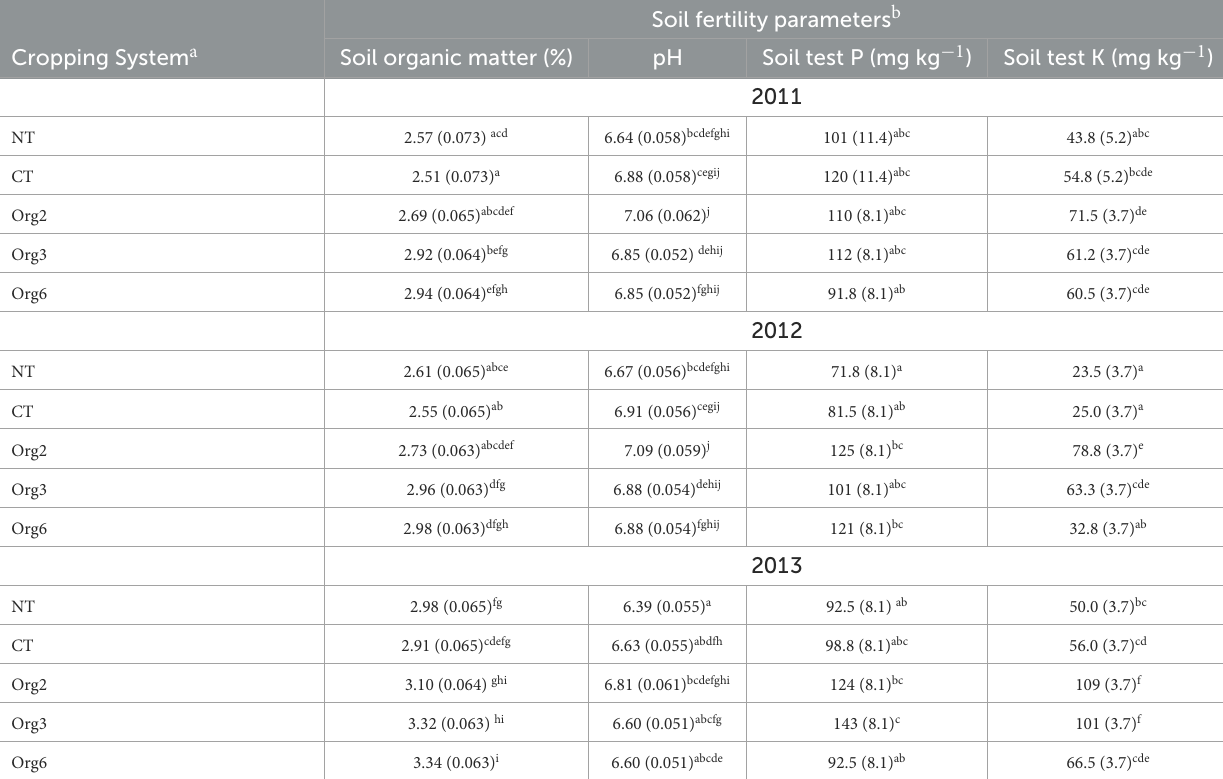
TABLE 4 Stepwise selected model mean and (SE) estimates of soil fertility parameters for FSP cropping systems collected to evaluate soil fertility requirements for maize in 2011, 2012, and 2013; multiple comparison letters ( α = 0.01) following the SE are relevant only within a given column. Soil fertility parameters